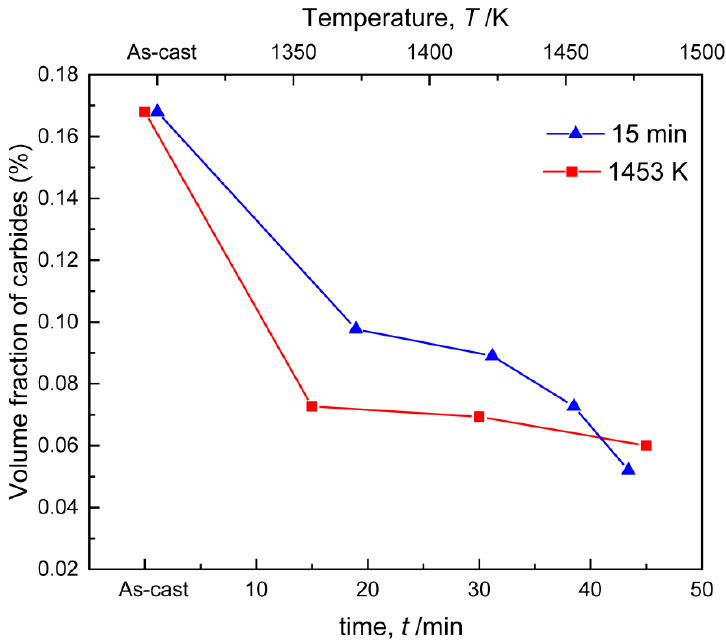
Figure 8. The volume fraction of carbides in the specimens with different holding time and austenitizing temperatures.